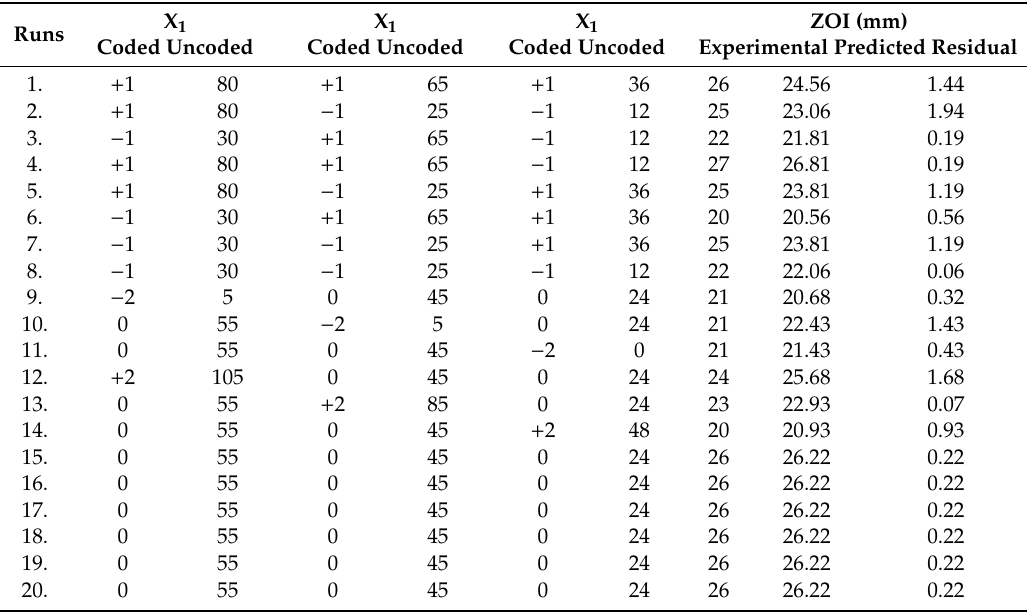
Table 4. CCD for formulation and optimization of ‘ZnO NP–Ams’ nanoantibiotic.